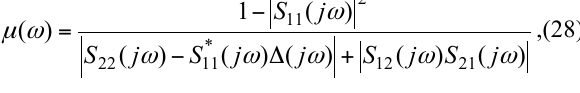
Figure 7: NGD circuit shown in Figure 2 loaded by R Ω .